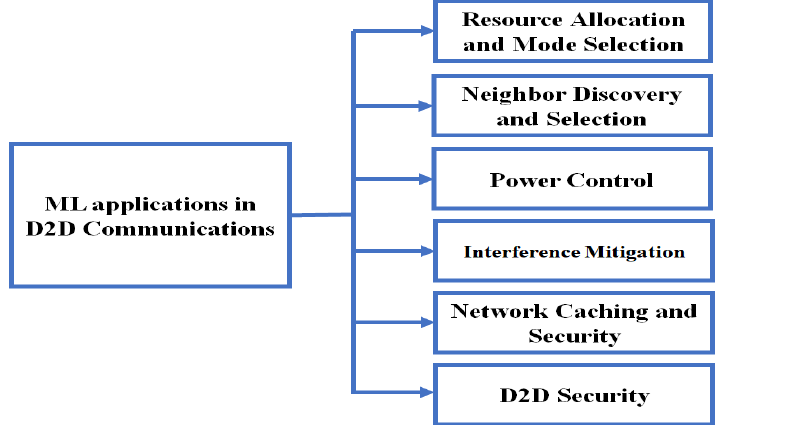
Figure 3. Machine-learning (ML) applications in D2D